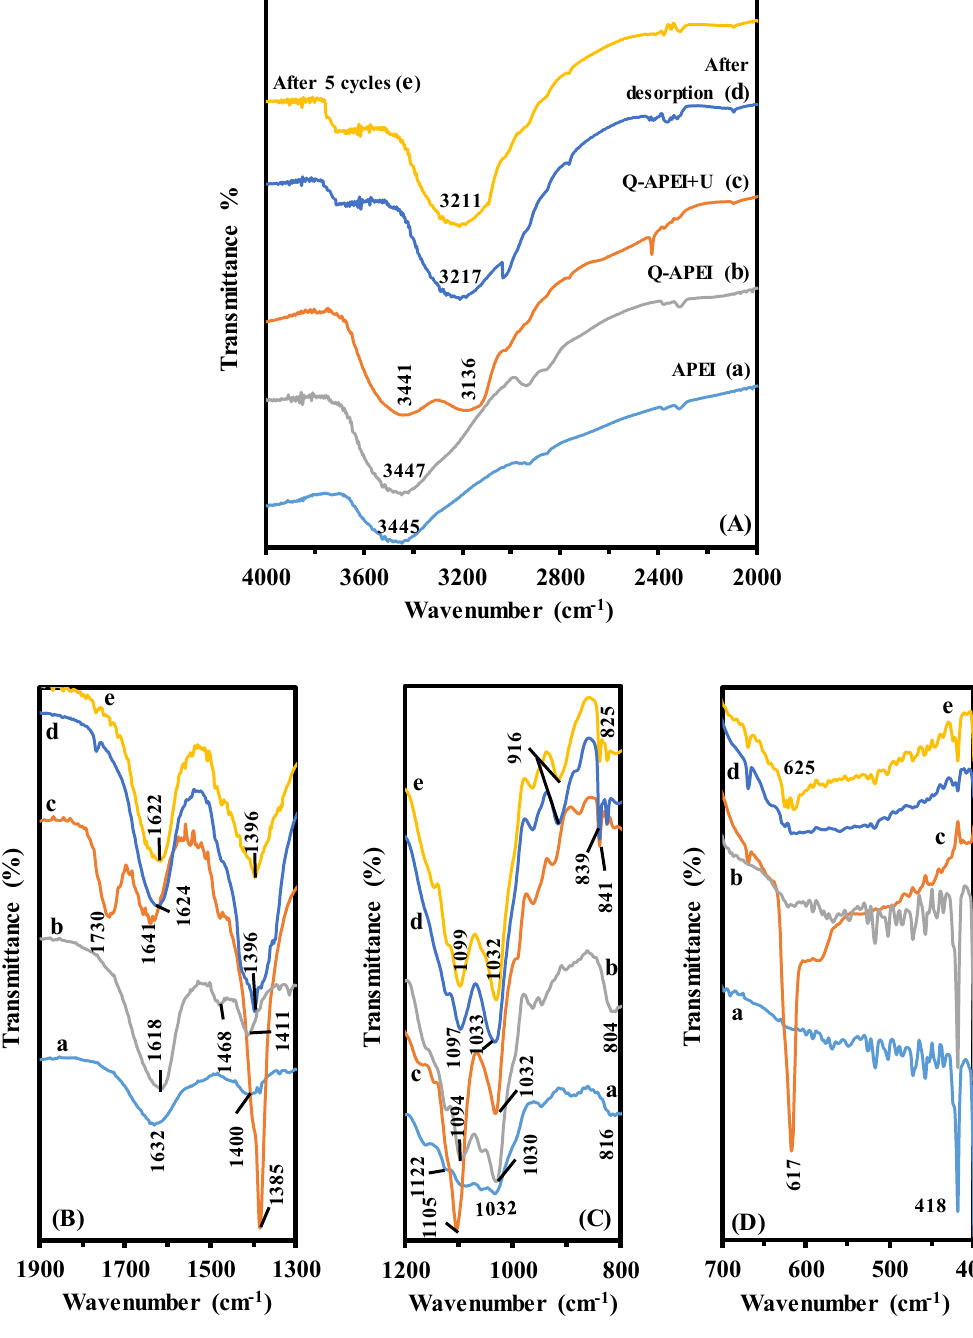
Figure 1. FTIR spectra (selected wavenumber ranges).